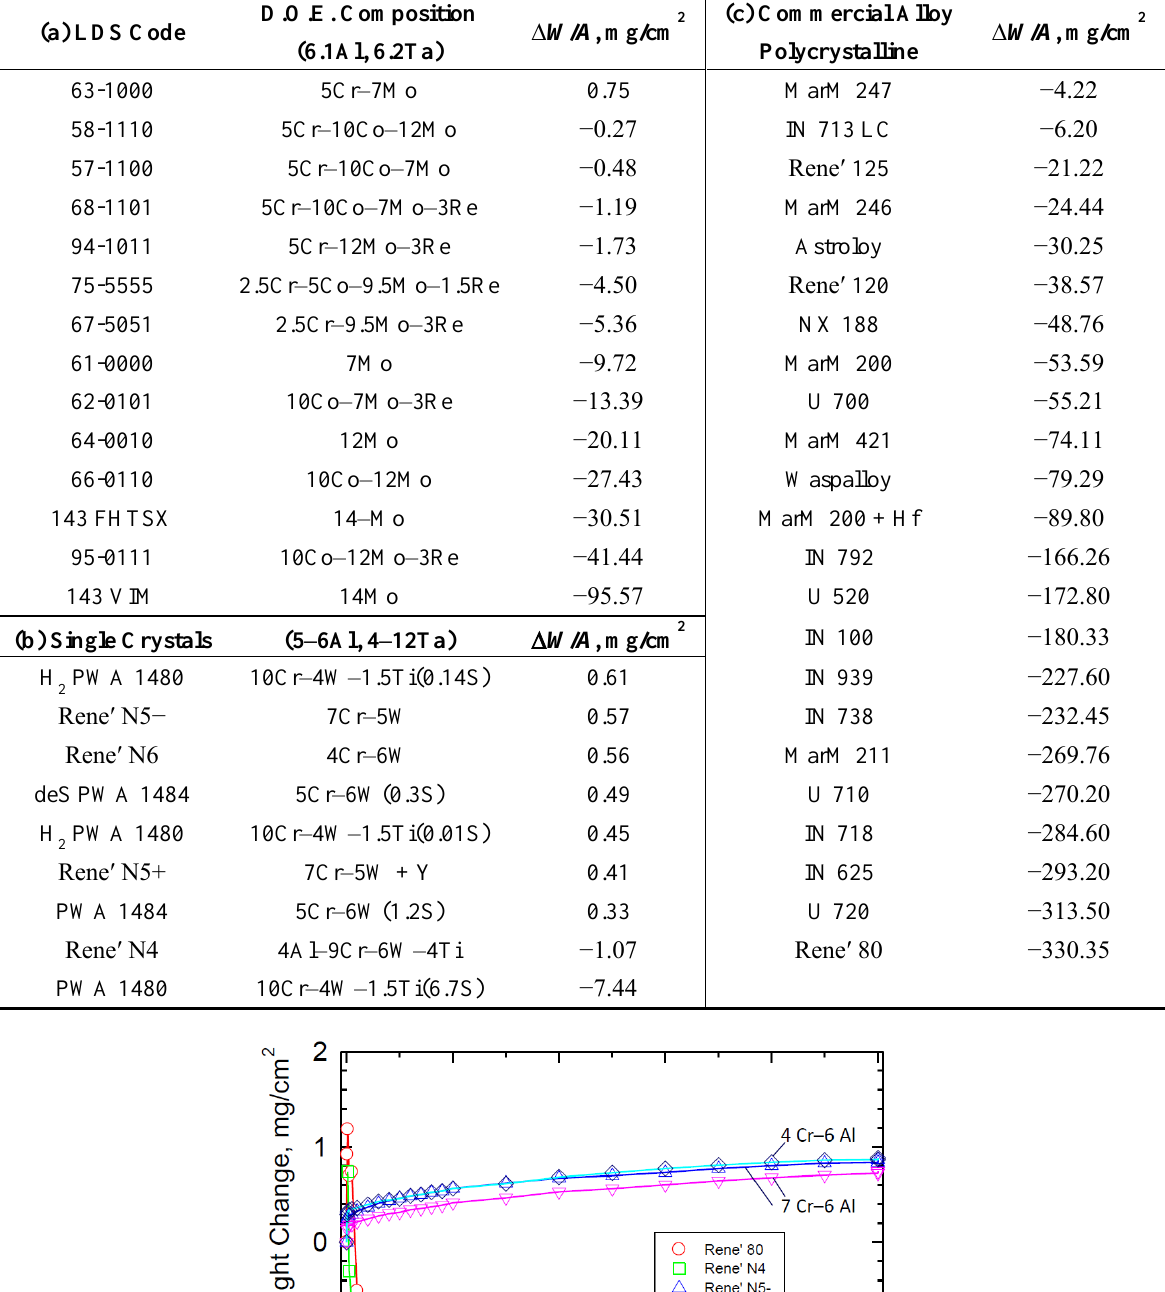
Table 2. Comparative ranking of ( a ) LDS VIM alloys, ( b ) single crystals and ( c ) conventional commercial alloys for 1100 °C, 200 h cyclic oxidation mass change (From Barrett database).